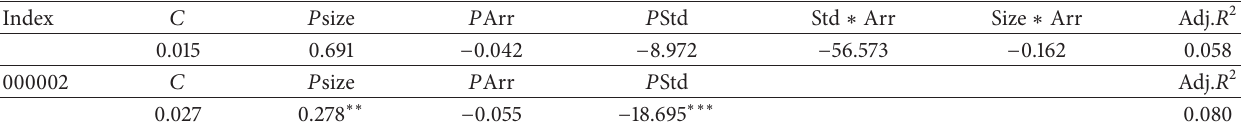
Table 11: Forecasting one-month-ahead index returns using realized jump volatility-based factor model with cross-term of its jump